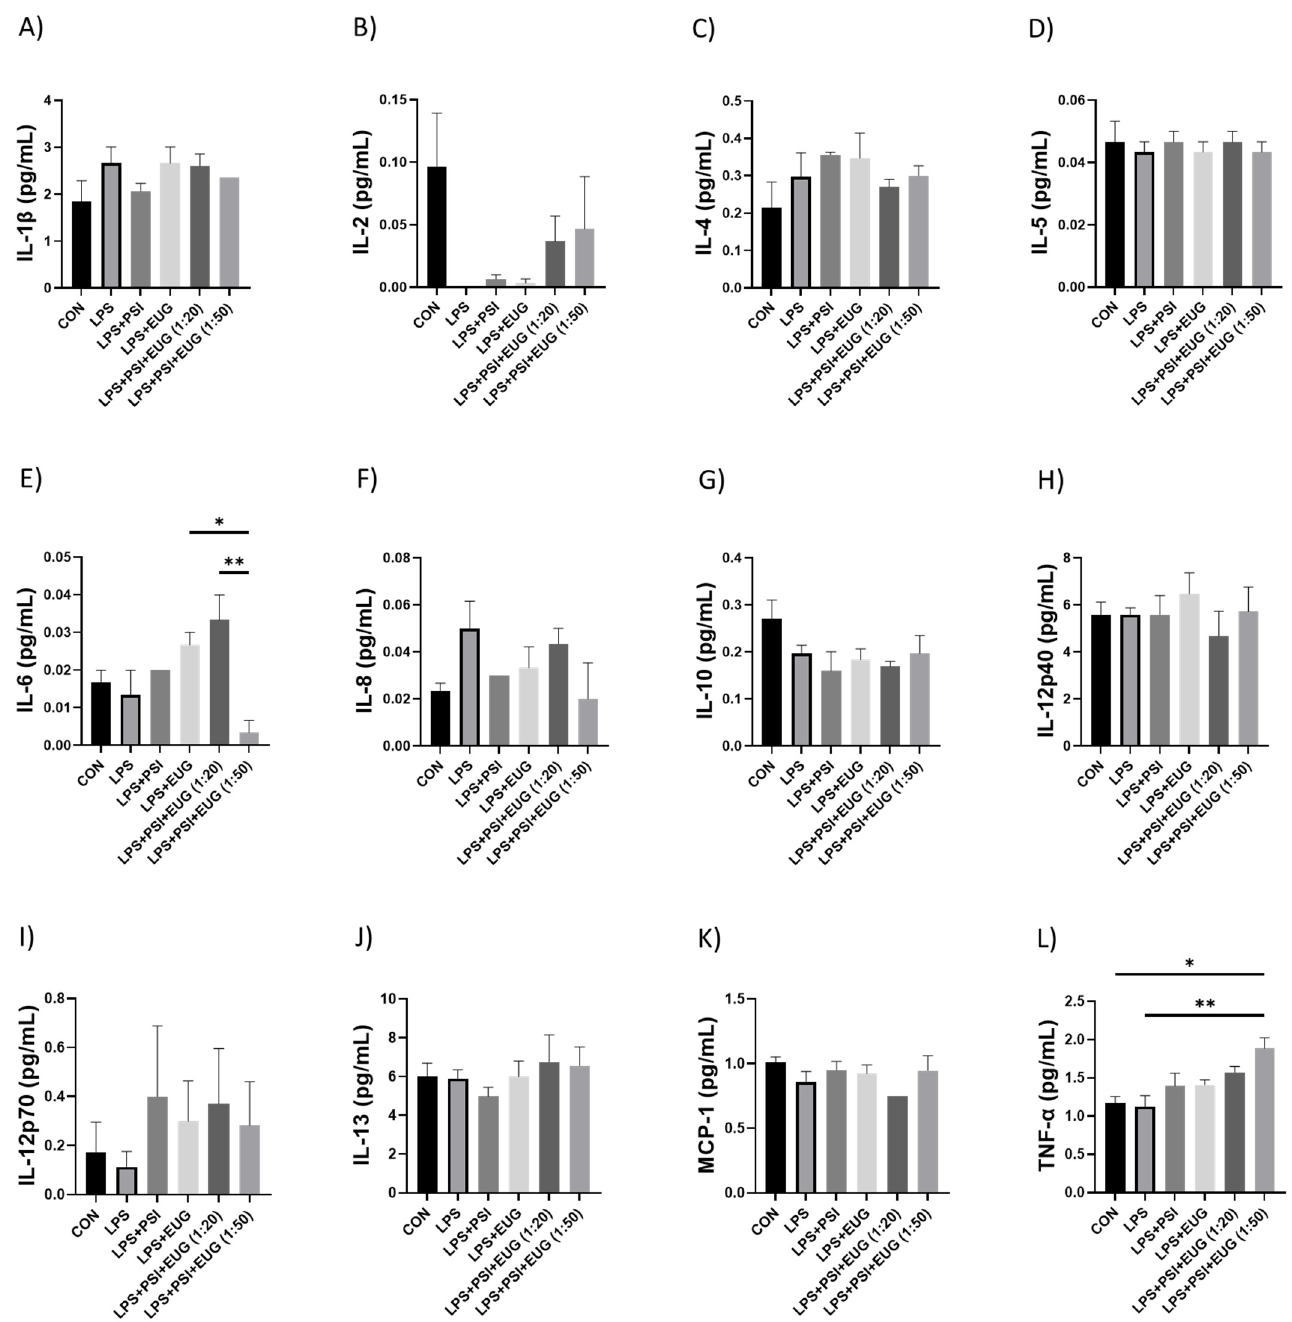
combined treatment group (1:50) compared to the LPS group (Figure 8L, p < 0.01). No other significant differences were observed (Figure 8).